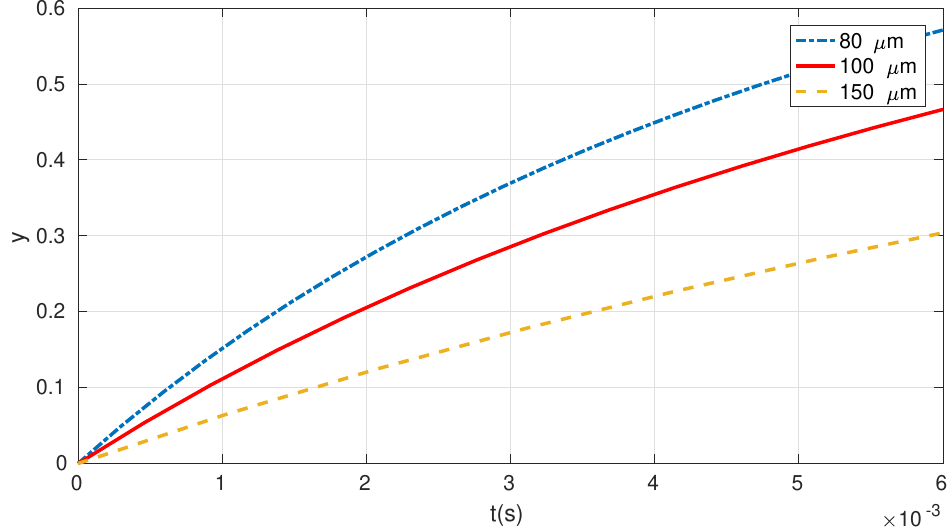
Figure 4. The temporal progress of the fractional velocity gain for droplets whose sedimentation time exceeds their evaporation time. The evaporation indicates the transformation of droplets into airborne aerosols. The drug force for such droplets is driven by an intermediate